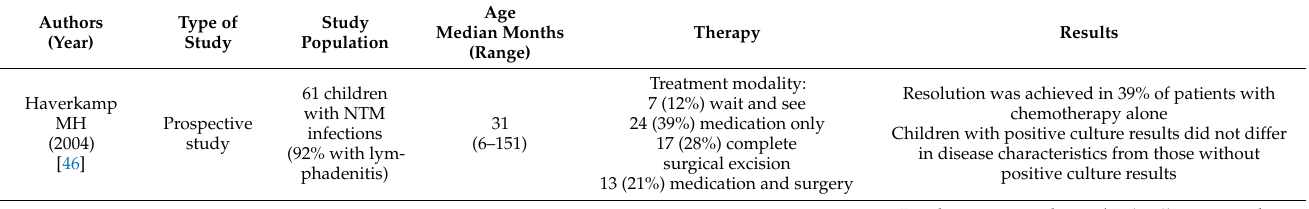
Table 3. Main studies on the management of nontuberculous mycobacteria (NTM) lymphadenitis in pediatric